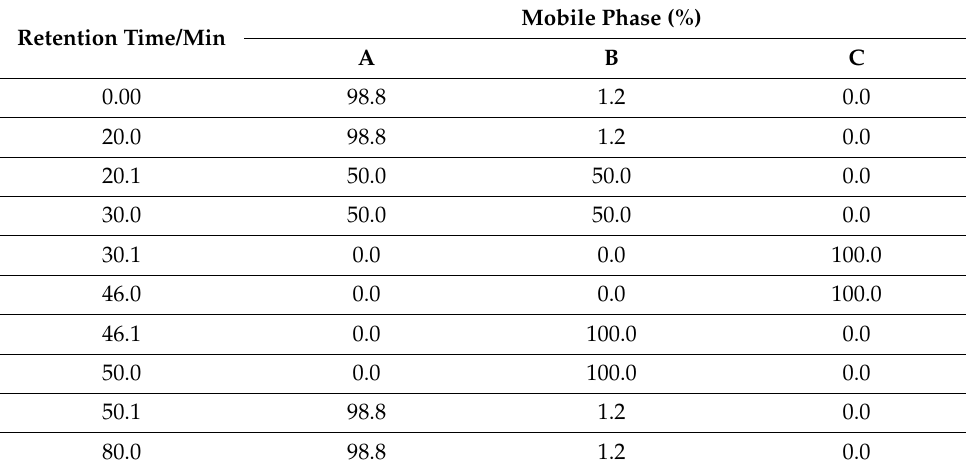
Table 1. Gradient elution